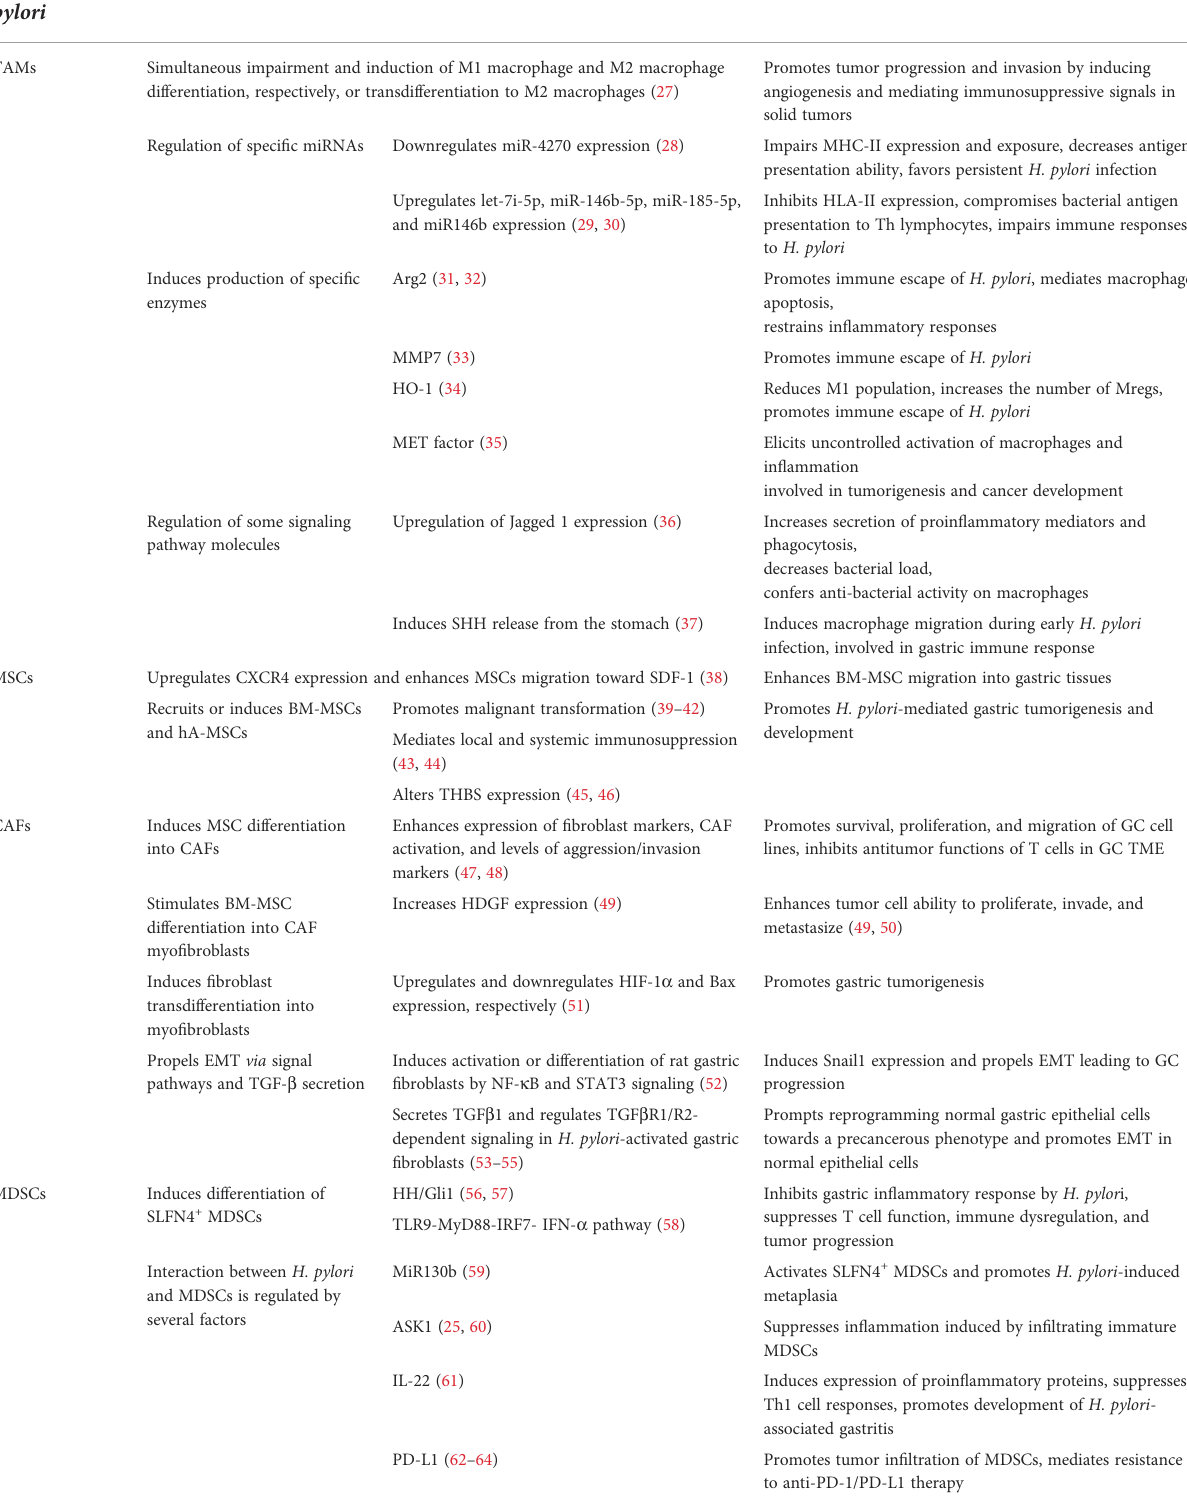
TABLE 1 Effects of H. pylori on tumor cells in gastric tumor immune microenvironment. Tumor cells affected by